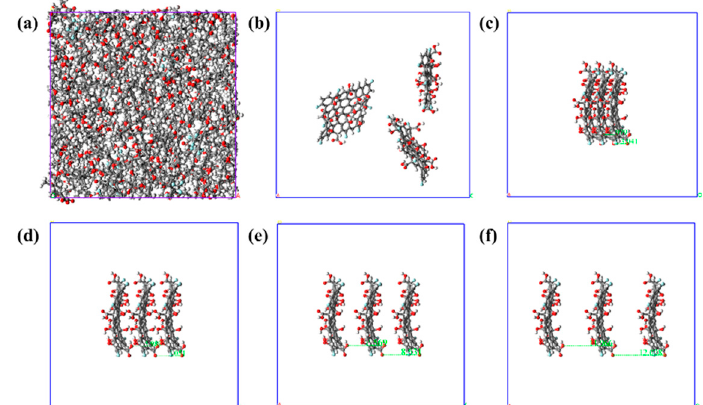
Figure 2. Molecular models. ( a ) Unfilled F-EP. ( b ) F-EP with disorderly filled FGO nanosheets. Figure ( c ) to ( e ) are the F-EP composite models with ordered filling of FGO (epoxy resin molecules are hidden). The layer spacing of each model is as follows: ( c ) 3 Å, ( d ) 6 Å, ( e ) 9 Å, ( f ) 12 Å.